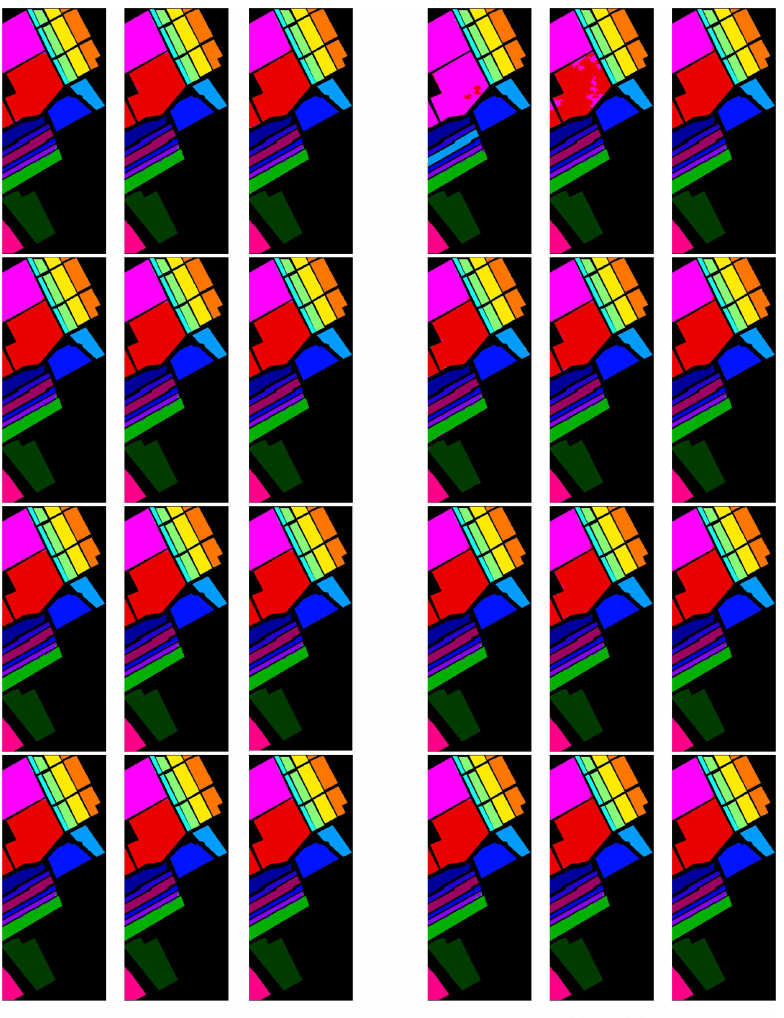
Figure 10. The classification maps of baselines and SALP over four classifiers on the Salinas dataset when ( a ) ρ = 0.1 and ( b ) ρ = 0.5. From the top row down to the last row: NN, SVM, RF, and ELM, from the first column to the last column: NLA, RLPA, and SALP. Please zoom in to see the